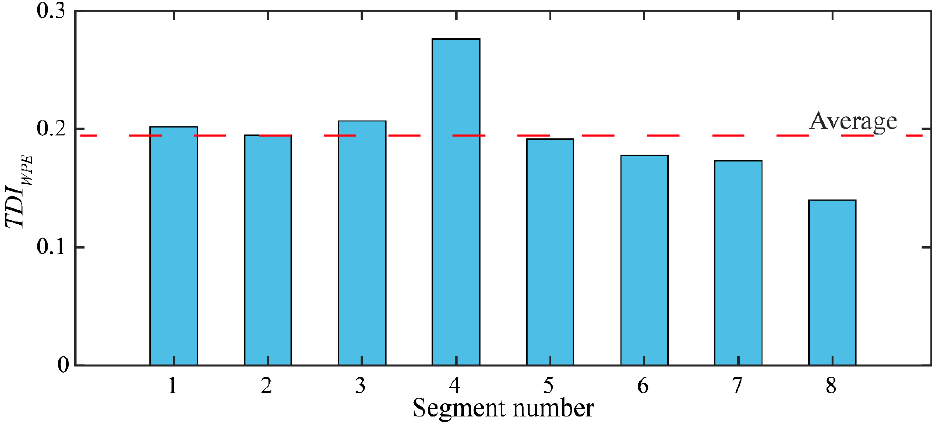
Figure 10. Identify void position using TDI WPE taking sample-A as an example.